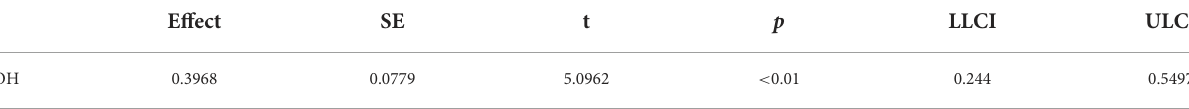
TABLE 5 Indirect effect(s) of OH on JE.